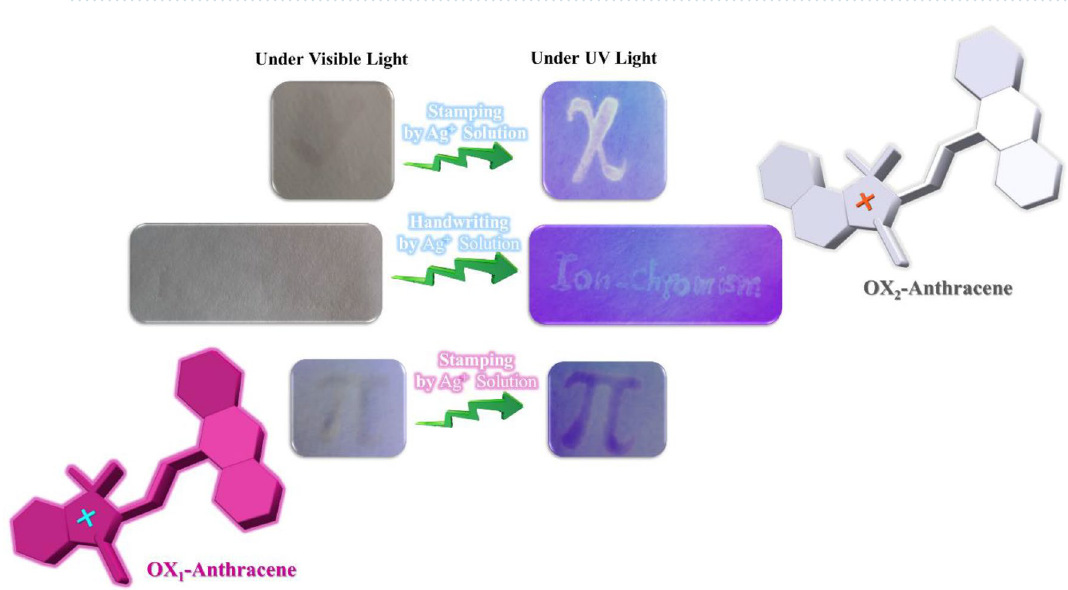
Figure 7. Handwriting and stamping of Ag + aqueous solutions on the ionochromic security papers coated with OX 1 -Anthtacene and OX 2